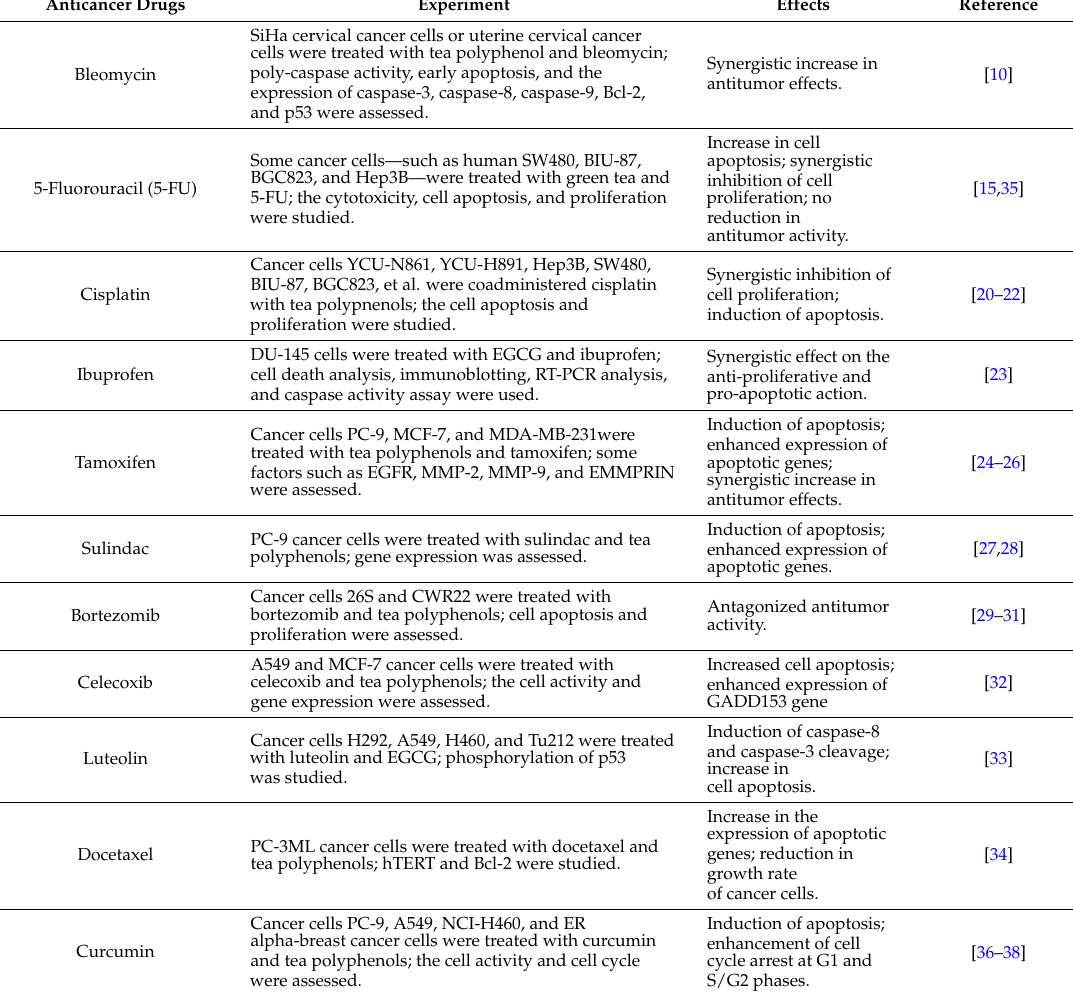
Table 1. The effects of green tea catechins on anticancer compounds in anti-tumor activity. Anticancer